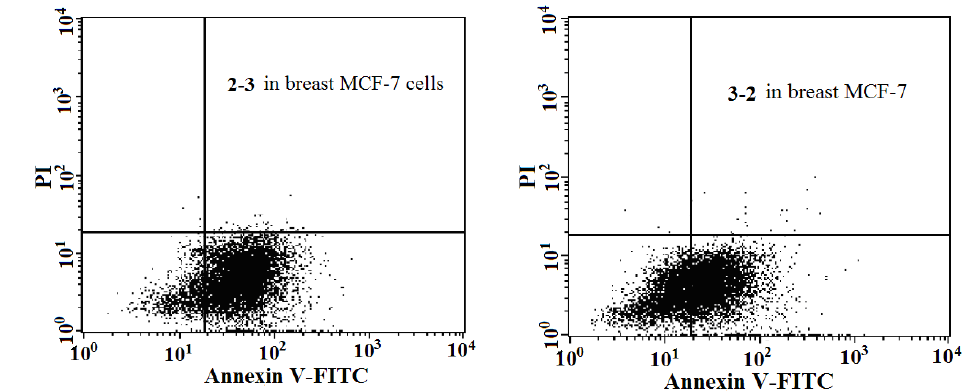
Figure 3. Apoposis induced by 2-3 and 3-2 in breast MCF-7